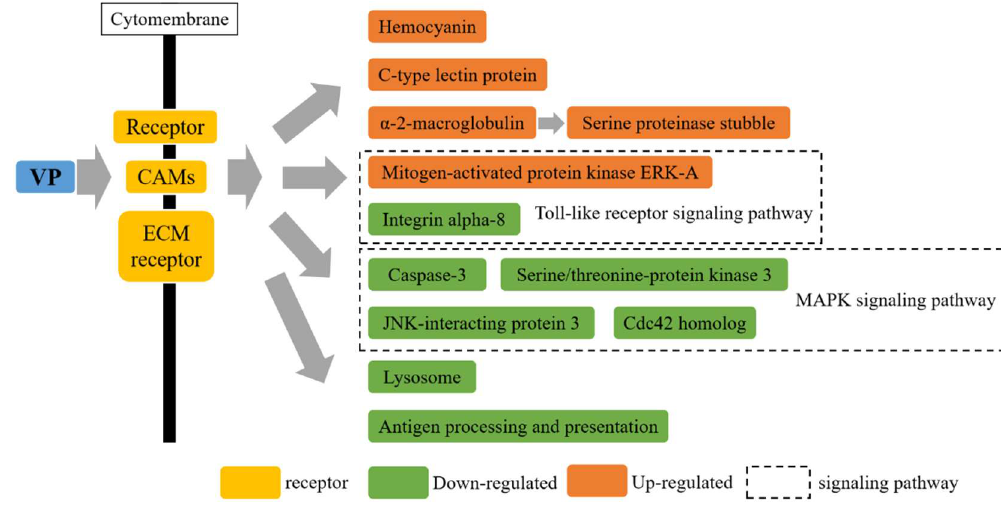
Figure 6. Immune system of P. trituberculatus reacted to V. parahaemolyticus infection.